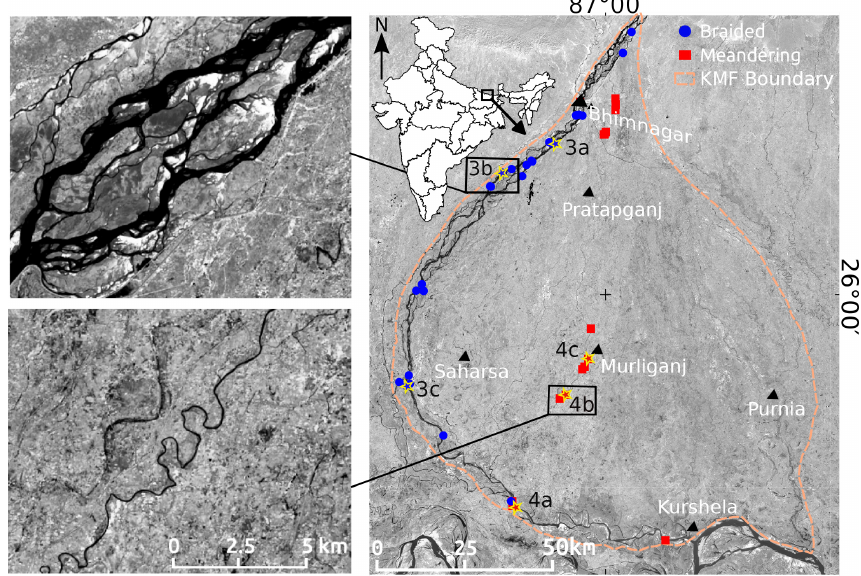
Figure 1. The Kosi megafan (KMF) boundary shown on Landsat 8 satellite image (acquired on 11 November 2013). Red and blue points on the image show the locations of cross-section measurements. Blue (a–c) and red (a–c) star marks highlighted with yellow boundaries show the location of braided and meandering cross-sections of Figs. 3 and 4. Top and bottom left images show the typical pattern of multiple-thread braided and single-thread meandering channels at the same scale (source of Landsat images: US Geological Survey).